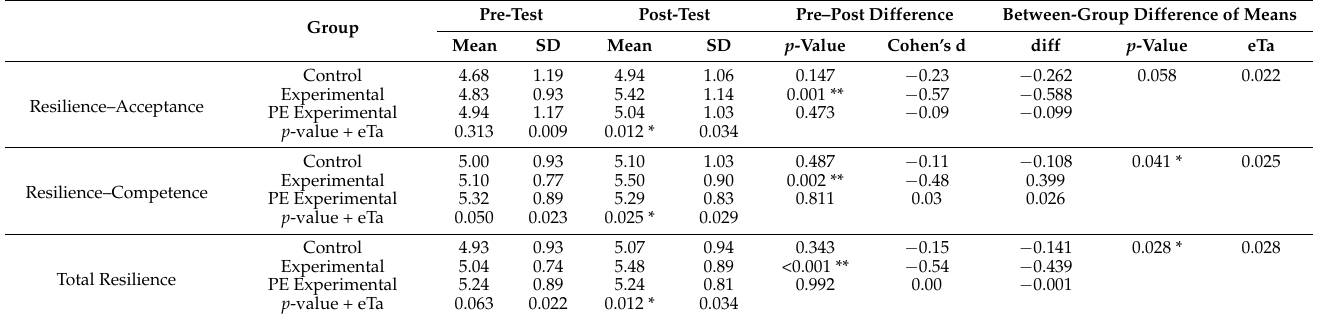
Table 5. Resilience